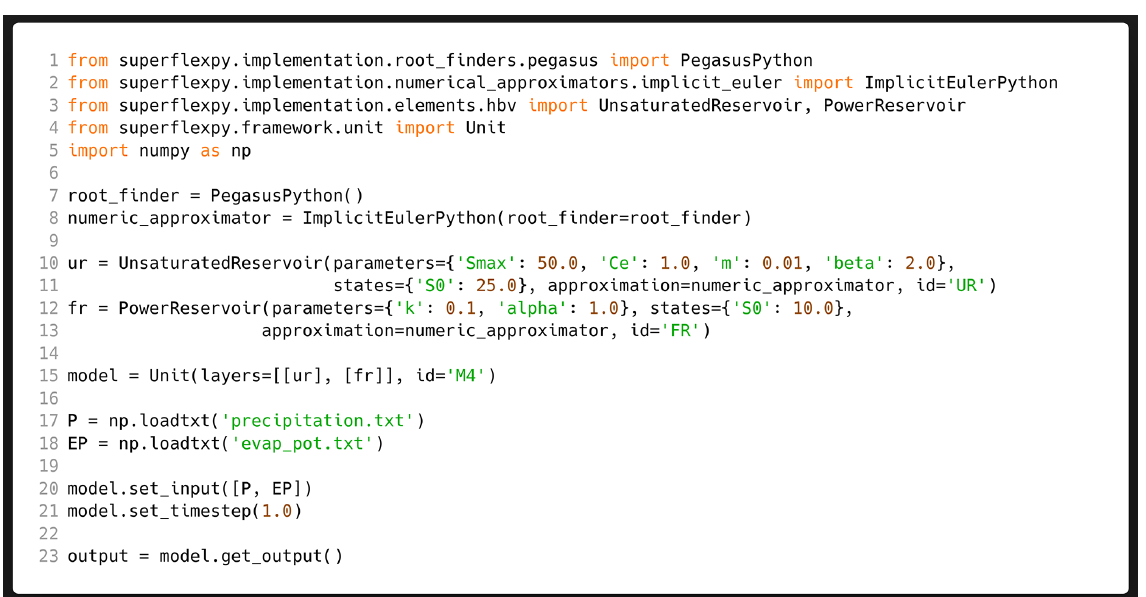
Figure 4. SuperflexPy code implementing model M4 in Fig.